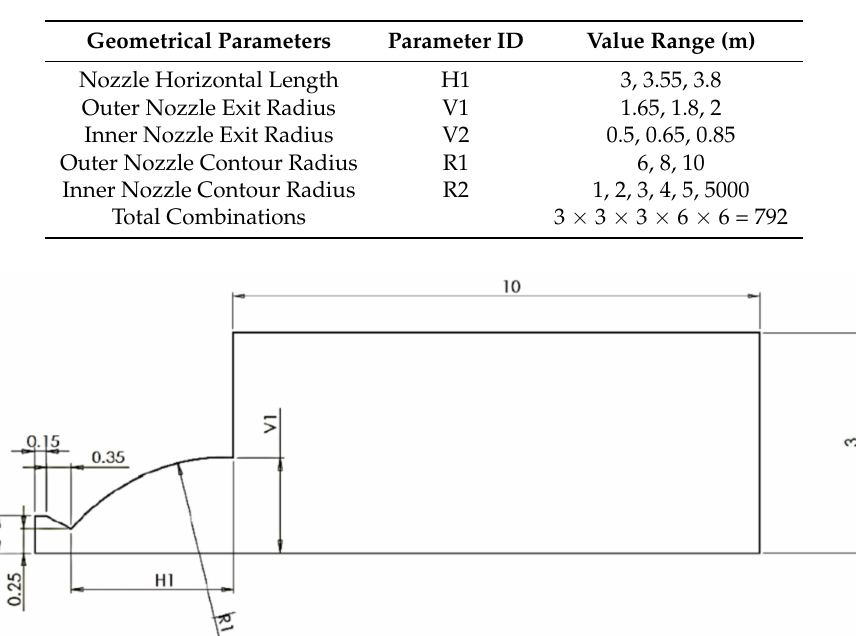
Table 5. Dual nozzle dimensional range.